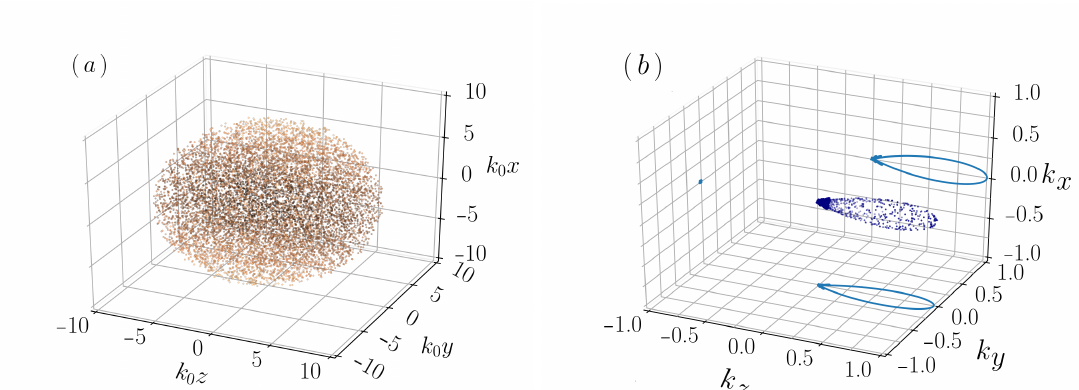
Figure 8. Initial atomic distribution, in ( a ), and bunching factor, in ( b ), of a spherical 3D atomic cloud, with N = 10 4 , irradiated with a transversely polarized pump field propagating parallel to its major